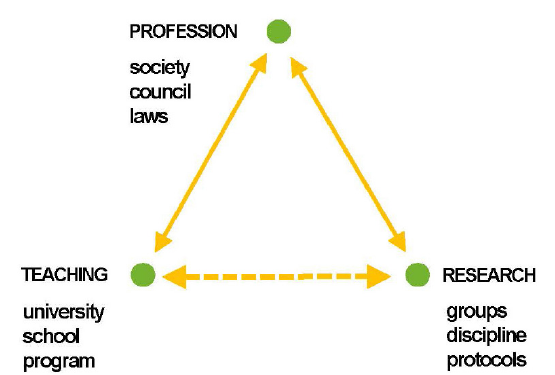
Figure 1. Areas of work and reflection in the schools of